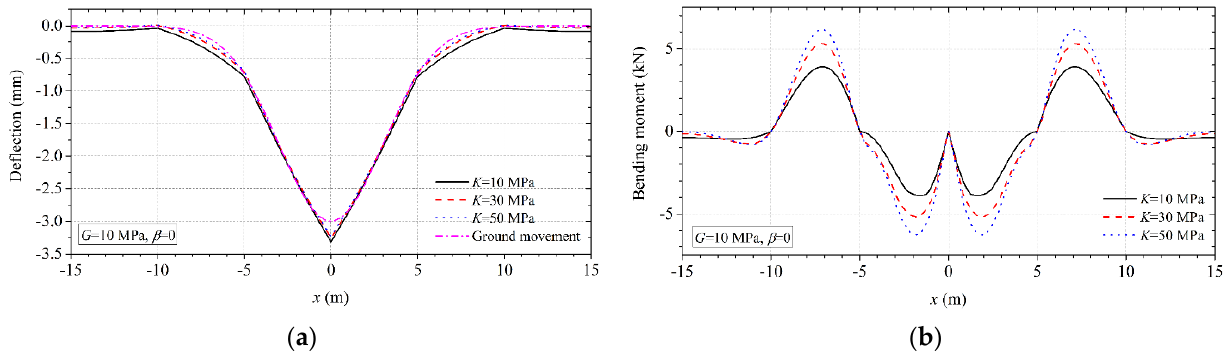
Figure 13. Deflection and bending moment of buried pipeline with different coefficients of subgrade reaction: ( a ) deflection; ( b ) bending moment.